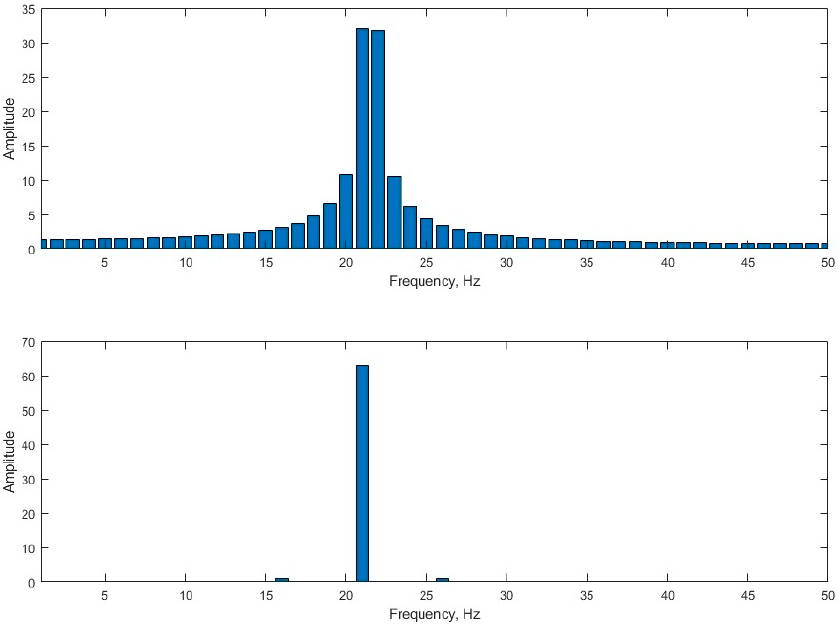
Figure 16. DFT (up) and NC (down) spectrum of mono-harmonic signal with 20.5 Hz.